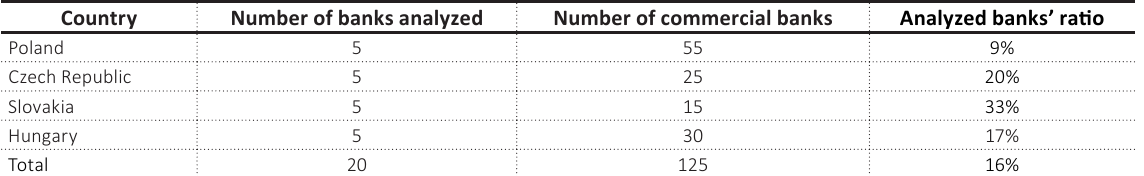
Table 1. The sample